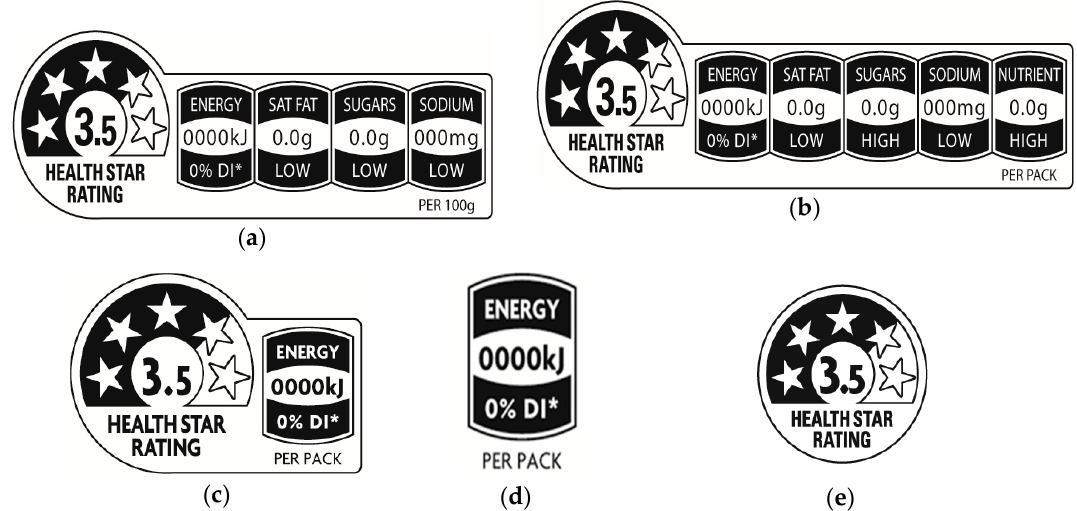
Figure 1. Health Star Rating System (HSR) System labelling options: ( a ) HSR with energy and three nutrient icons; ( b ) HSR with energy and four nutrient icons; ( c ) HSR with energy icon; ( d ) Energy icon only; ( e ) HSR with no additional icon (Source: Food Standards Australia New Zealand [41]).